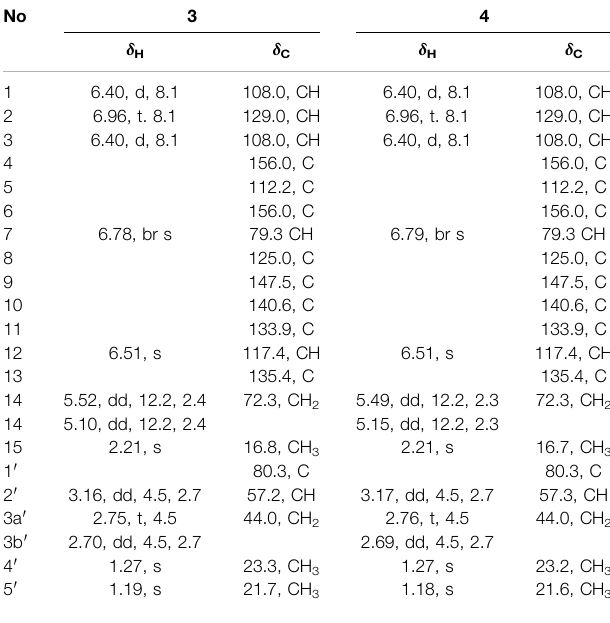
TABLE 2 | 1 H (600 MHz) and 13 C (150 MHz) NMR data of 3 and 4 in CD 3 COCD 3